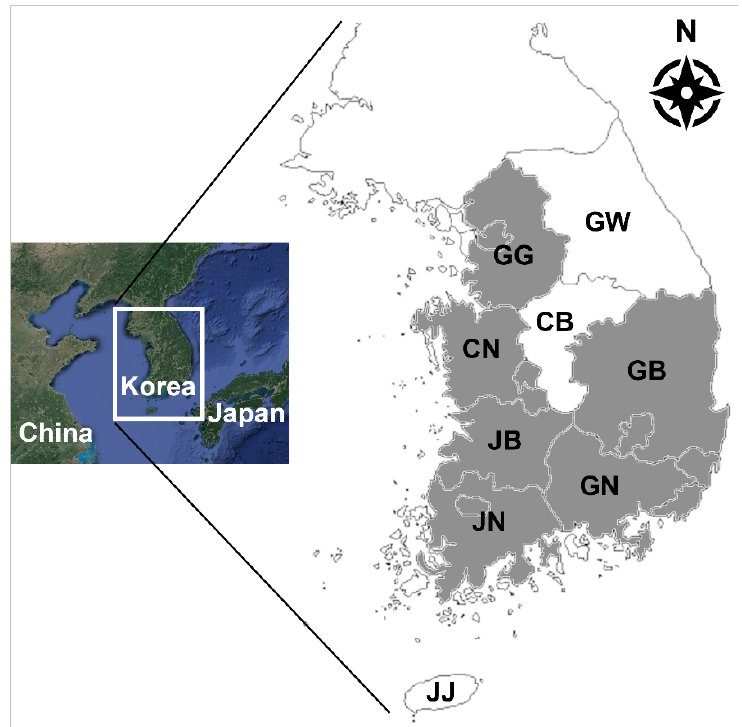
Figure 1. Map of Korea. The sites of pigs reared are indicated in gray. GG, Gyeonggi-do; GW, Gangwon-do; CN, Chungcheongnam-do; CB, Chungcheongbuk-do; GB, Gyeongsangbuk-do; GN, Gyeongsangnam-do; JB, Jeollabuk-do; JN, Jeollanam-do; JJ, Jeju-do.